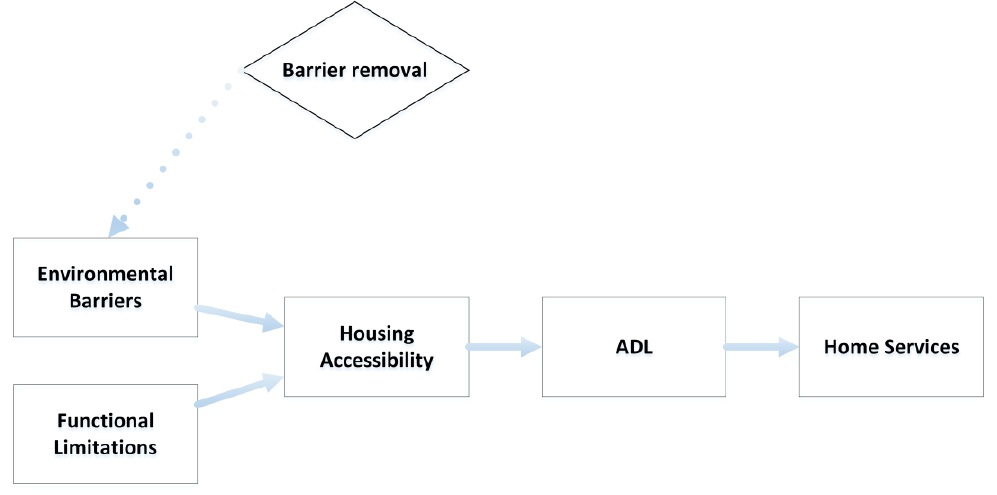
Figure 1. Theoretical model.